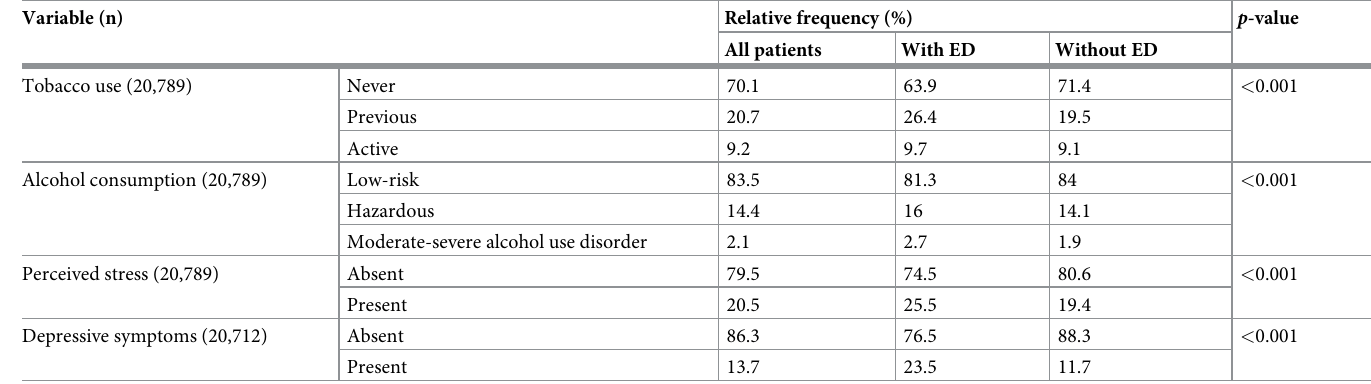
Table 5. Relative frequencies of tobacco use, risky alcohol consumption, perceived stress, depressive symptoms, and lower urinary tract symptoms in relation to ED (n = 20,789).